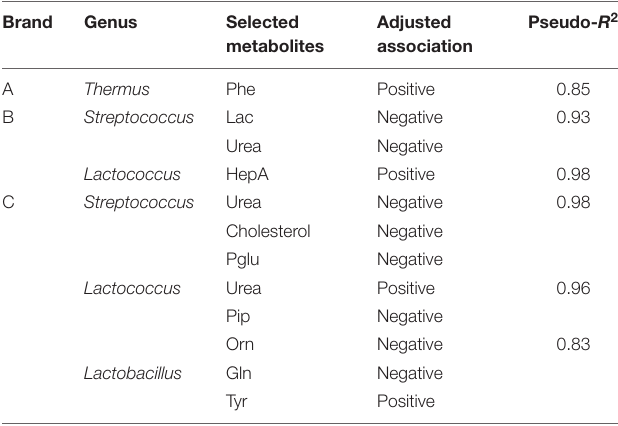
TABLE 1 | Adjusted associations between the bacterial genera and selected metabolites in the Random forest model to predict associations between genera and